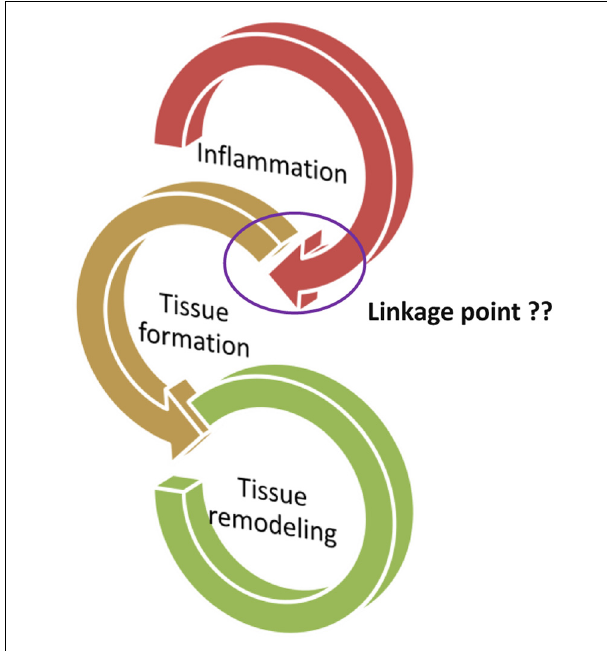
FIGURE 1 |The process from inflammation to the wound healing is divided into three phases: (1) Inflammation process, (2) tissue formation, and (3) tissue remodeling. The important question, “what is the key linkage between the tissue formation and